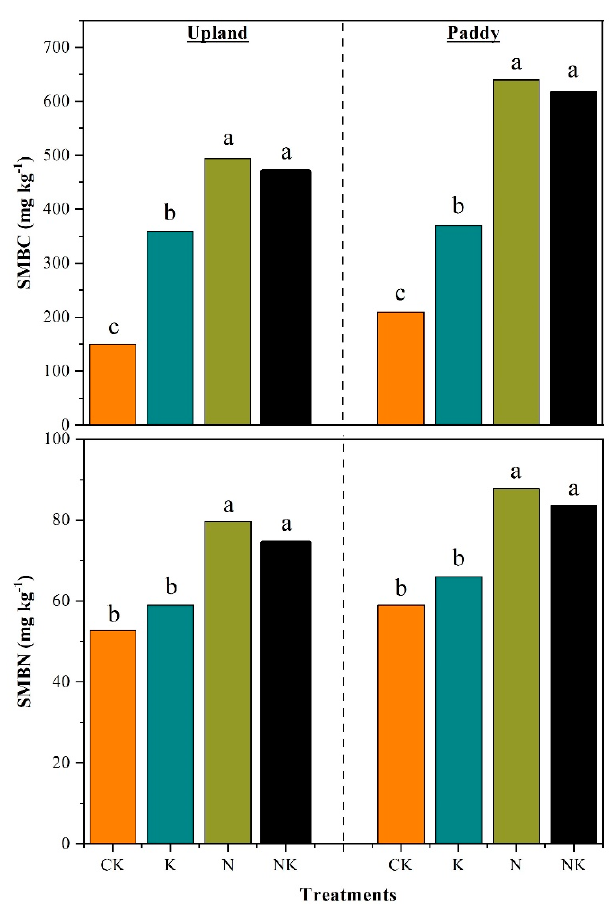
Figure 1. Soil microbial biomass C and N (SMBC, SMBN) concentrations under different fertilization treatments in upland and paddy soils. Notes: CK, no fertilizer; K, synthetic potassium; N, synthetic nitrogen and NK, synthetic nitrogen and potassium. Bars indicate the standard error, n = 3. Different letters indicate significantly different means at p < 0.05 using the least significance difference (LSD) test.